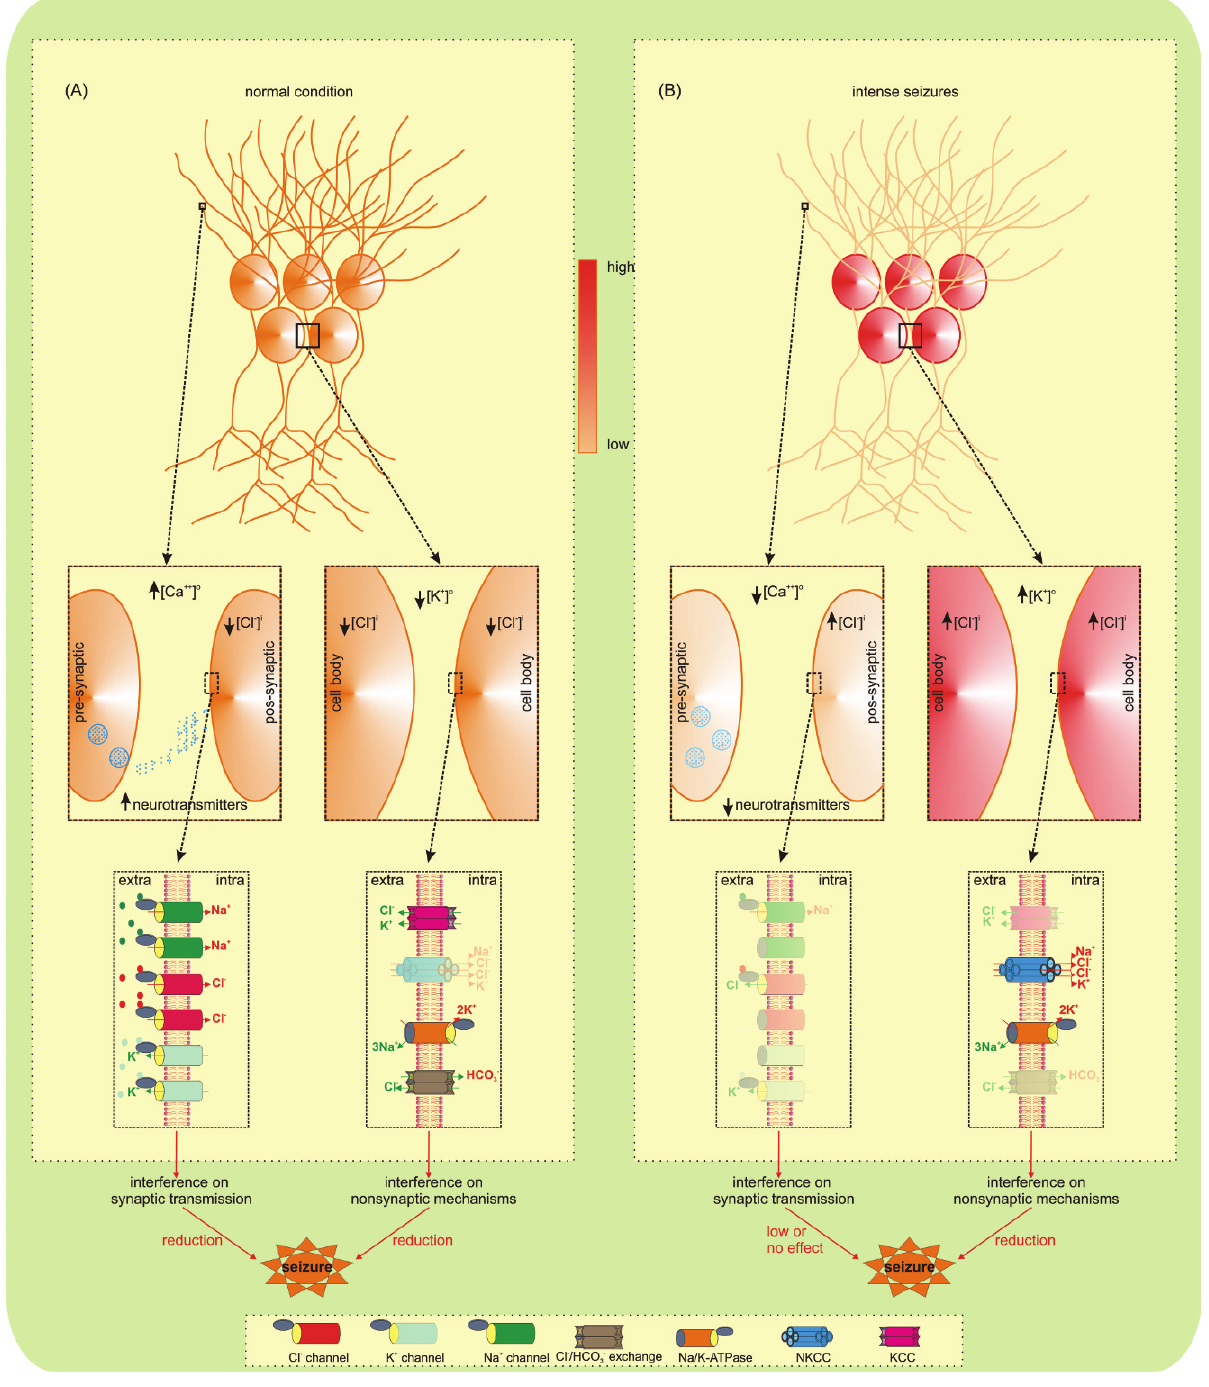
Figure 1 - Diagrammatic representation of conditions in which interference on synaptic transmission and/or non-synaptic mechanisms may affect seizures. Under normal ionic conditions, neuronal activity is not accompanied by important changes in the ionic concentrations (left). Therefore, the ionic gradients support effective actions of the synaptic transmission and non-synaptic mechanisms to reduce seizures. Conversely, when the transmembrane ionic gradients are decreased (right), the synaptic transmissions are depressed and the interferences on the synaptic circuit are refractory. However, seizure reduction is expected when interfering with the non- synaptic mechanisms to restore ionic